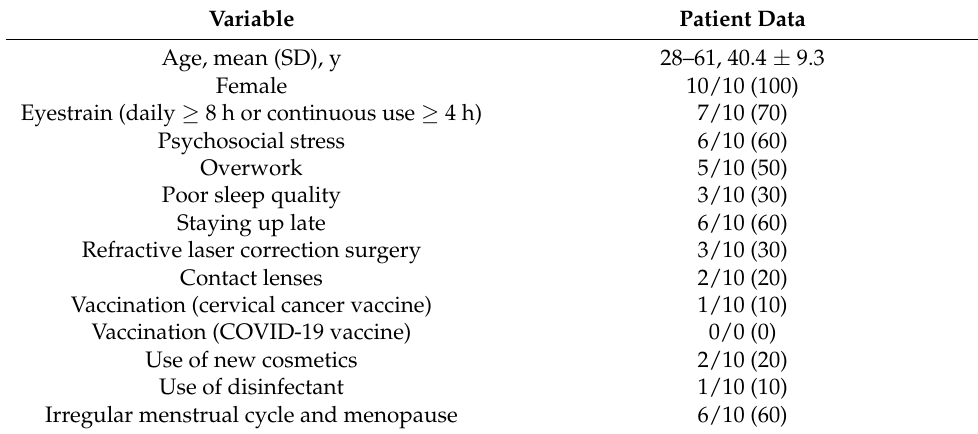
Table 1. Clinical Characteristics of Study